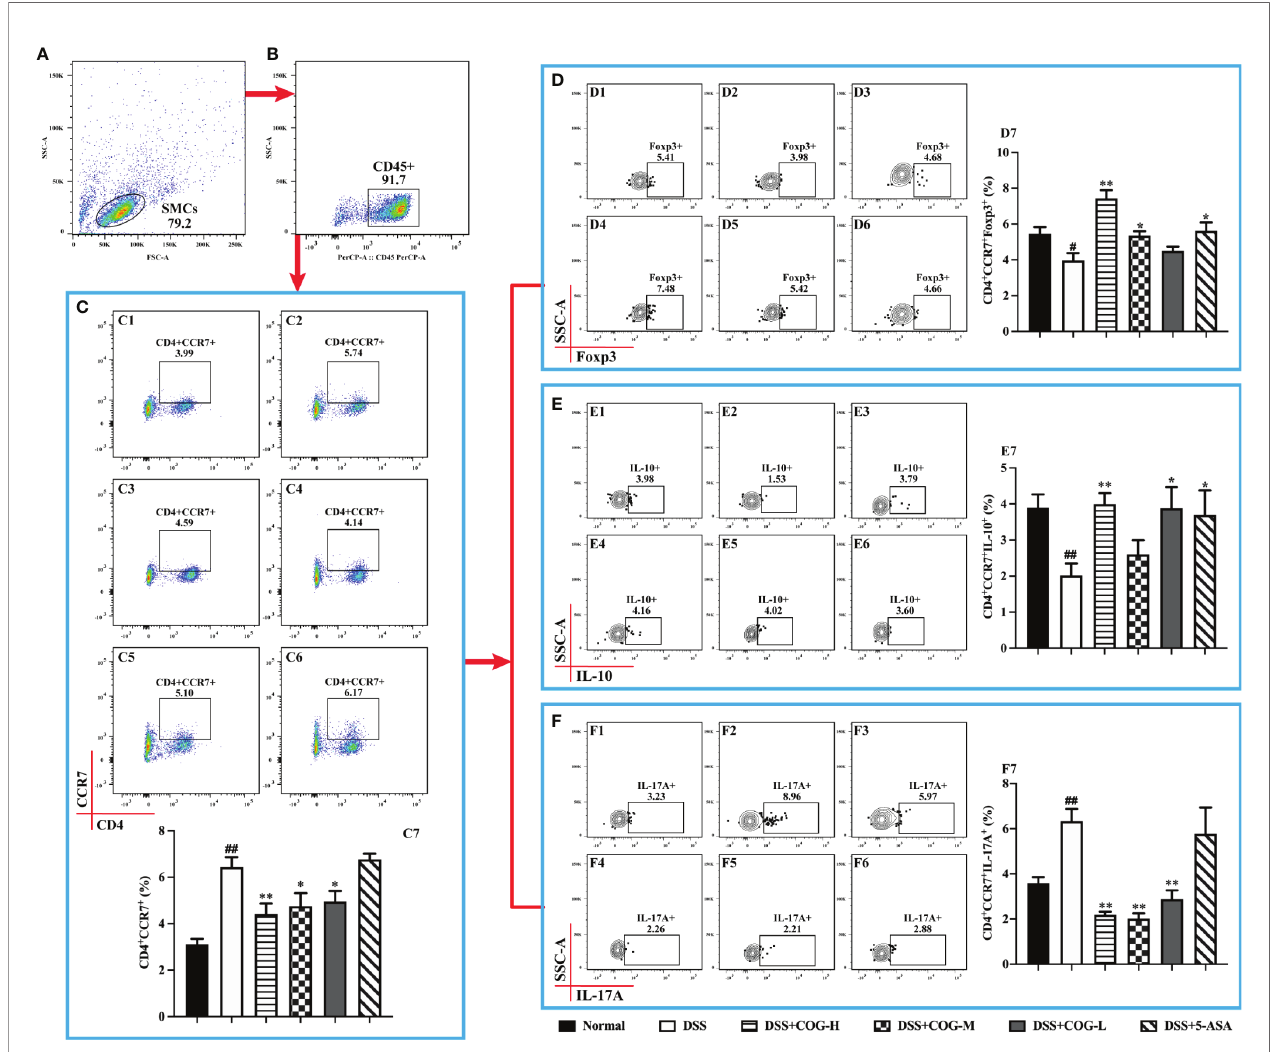
FIGURE 6 | COG regulated CCR7 + CD4 + T cells in mice with colitis. (A) Spleen mononuclear cells (SMCs). (B) CD45 + cells. (C) Flow cytometry analysis of CCR7 + memory T cells: C1 – C6 represent CCR7 + memory T cells in the normal, DSS, DSS+COG-H, DSS+COG-M, DSS+COG-L, and DSS+5-ASA groups, respectively; C7: statistical analysis of CCR7 + memory T-cell frequencies in these six groups. (D) Flow cytometry analysis of Foxp3 + CCR7 + memory T cells: D1 – D6 represent Foxp3 + CCR7 + memory T cells in the normal, DSS, DSS+COG-H, DSS+COG-M, DSS+COG-L, and DSS+5-ASA groups, respectively; D7: statistical analysis of Foxp3 + CCR7 + memory T-cell frequencies in these six groups. (E) Flow cytometry analysis of IL-10 + CCR7 + memory T cells: E1 – E6 represent IL-10 + CCR7 + memory T cells in the normal, DSS, DSS+COG-H, DSS+COG-M, DSS+COG-L, and DSS+5-ASA groups, respectively; E7: statistical analysis of Foxp3 + CCR7 + memory T-cell frequencies in these six groups. (F) Flow cytometry analysis of IL-17A + CCR7 + memory T cells: F1 – F6 represent IL- 17A + CCR7 + memory T cells in the normal, DSS, DSS+COG-H, DSS+COG-M, DSS+COG-L, and DSS+5-ASA groups, respectively; F7: statistical analysis of